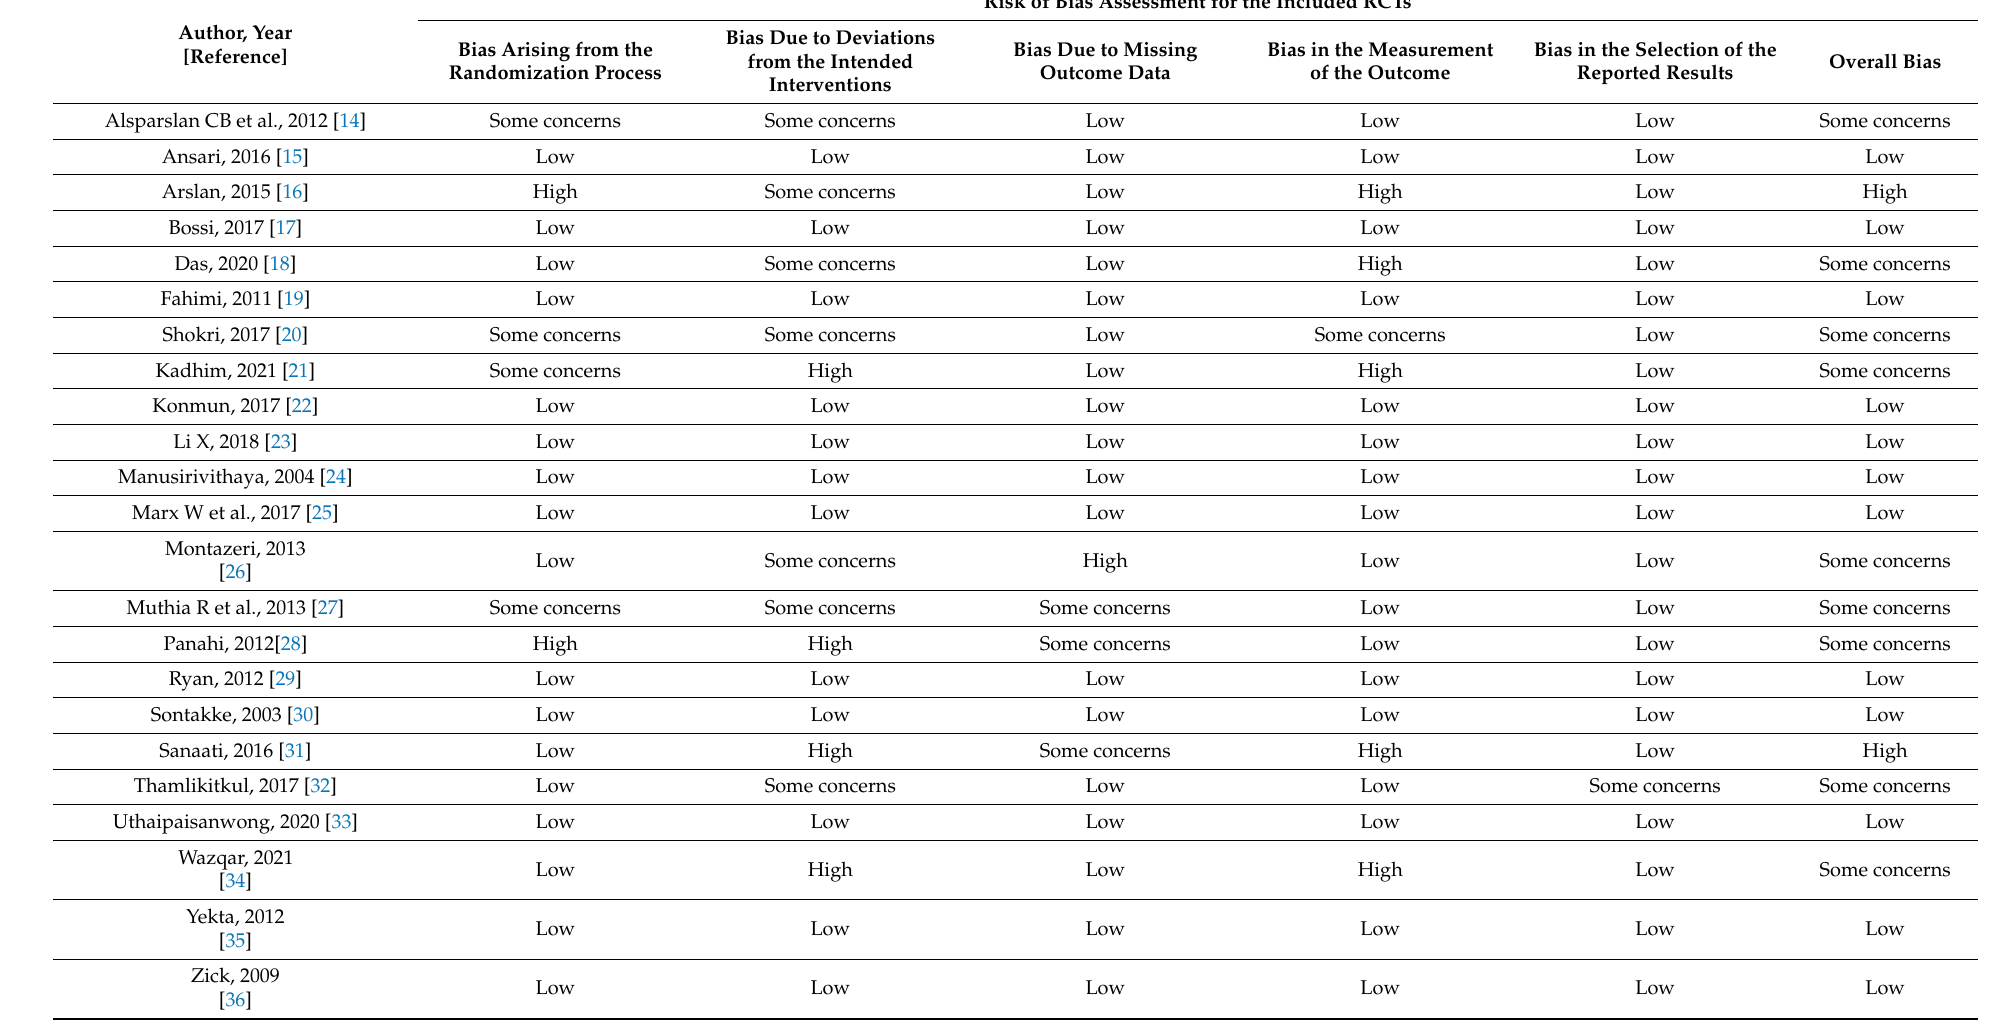
Table 2. Risk of bias assessment for the included